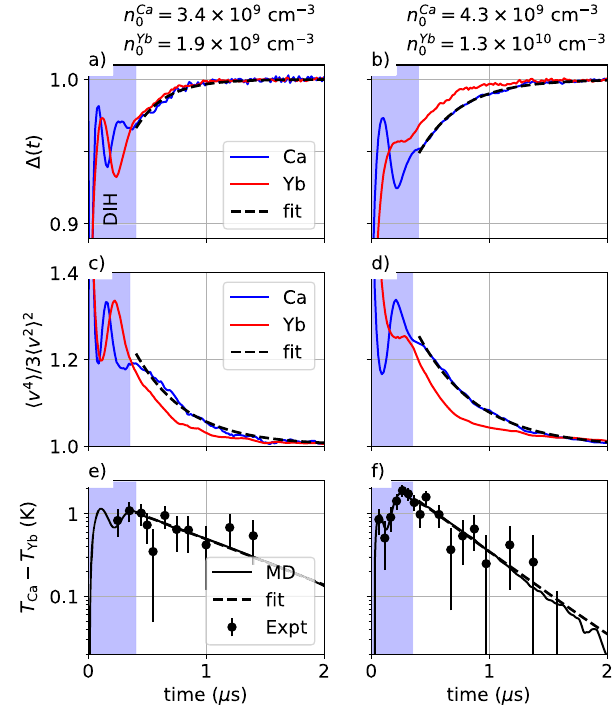
Fig. 3 Velocity and temperature difference analysis. Data from two dual- species ultracold neutral plasmas are shown. The top row a and b plots the fraction of the MD distribution f ( v , t ) that matches a Maxwellian distribution. In a , the Ca and Yb decay time is 250ns. In b , the Ca and Yb decay times are 360 and 270 ns, respectively. The middle row c and d shows the time evolution of the moment ratio h v 4 i = 3 h v 2 i 2 . In c , the Ca and Yb moment ratios decay exponentially, with time constants of 440 and 350 ns, respectively. In d , the decay constants are 515 and 380 ns. The bottom row e and f plots the temperature difference between the Ca and Yb ions. The agreement between the experiment (circles) and MD simulations (solid line) is readily apparent. The short vertical black lines represent estimated 1 σ uncertainties in the temperature difference. The exponential temperature relaxation time constants in e and f are 950 and 450 ns, respectively. The shaded regions indicate the disorder-induced heating (DIH) timescale. After the DIH process is complete, the two- temperature system is well established. The moment ratios are small and tend exponentially toward unity. For all of this data, the electron temperature is 96 K. A correction has been added to a and b to account for noise in the MD distribution at equilibrium. Data in e and f are reproduced from Silvestri, L. G. et al., Phys. Plasmas 28, 062302 (2021), with the permission of AIP